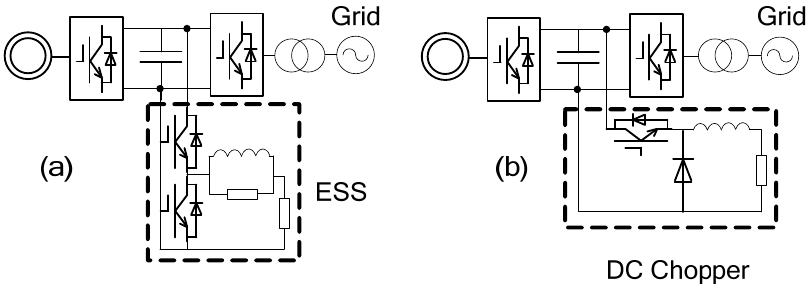
Figure 12. DC-link protection circuits. ( a ) ESS; ( b ) DC